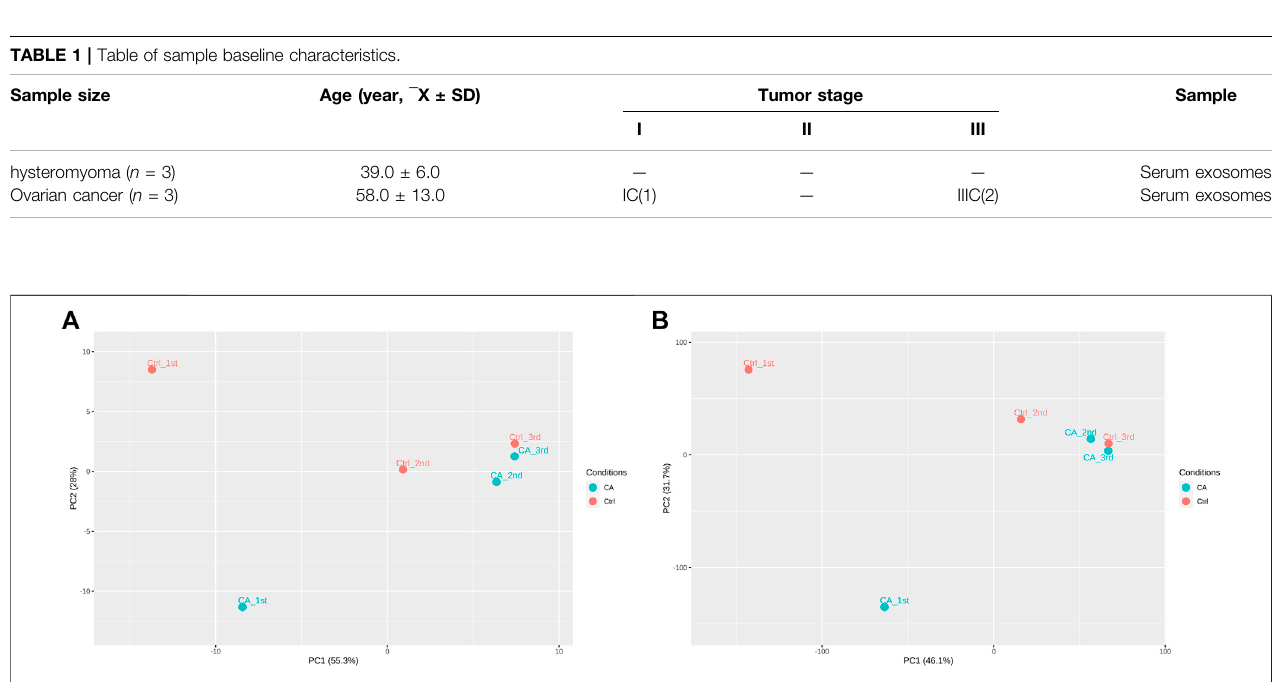
FIGURE 2 | PCA distribution of ovarian cancer sequencing data: (A) PCA distribution of lncRNA data. (B) PCA distribution of mRNA data.